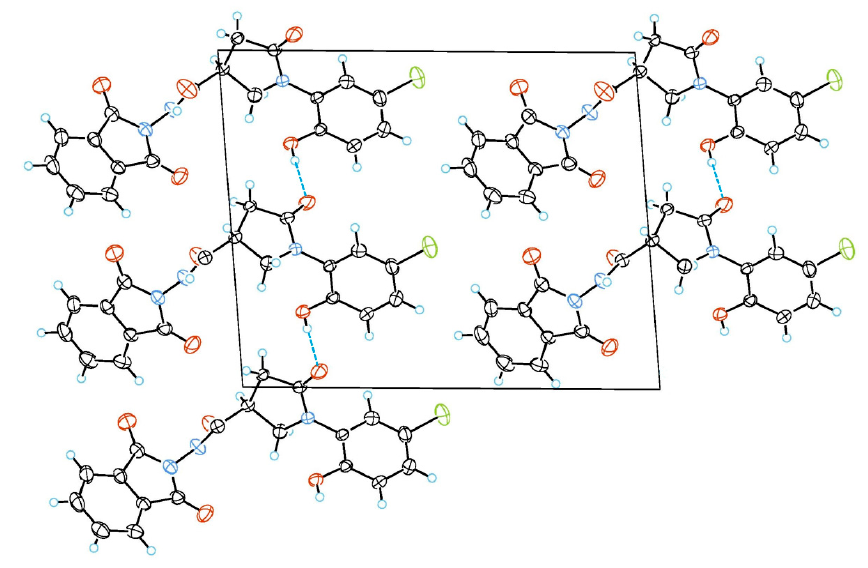
Figure 2. A projection of the crystal structure of 11 along monoclinic axis.